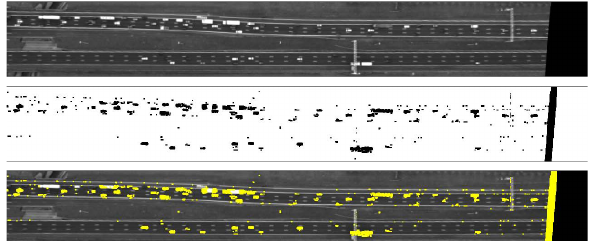
Figure 5: Vehicle identification. From top to bottom: 1) an ar- bitrary image 2) extracted blobs (black), and 3) highlighted ex- tracted blobs.